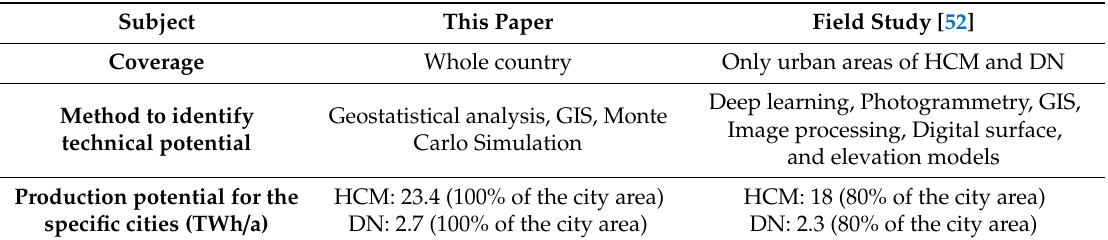
Table 3. Comparison of the results of the suggested model and the field study in Ho Chi Minh (HCM) and Da Nang (DN).